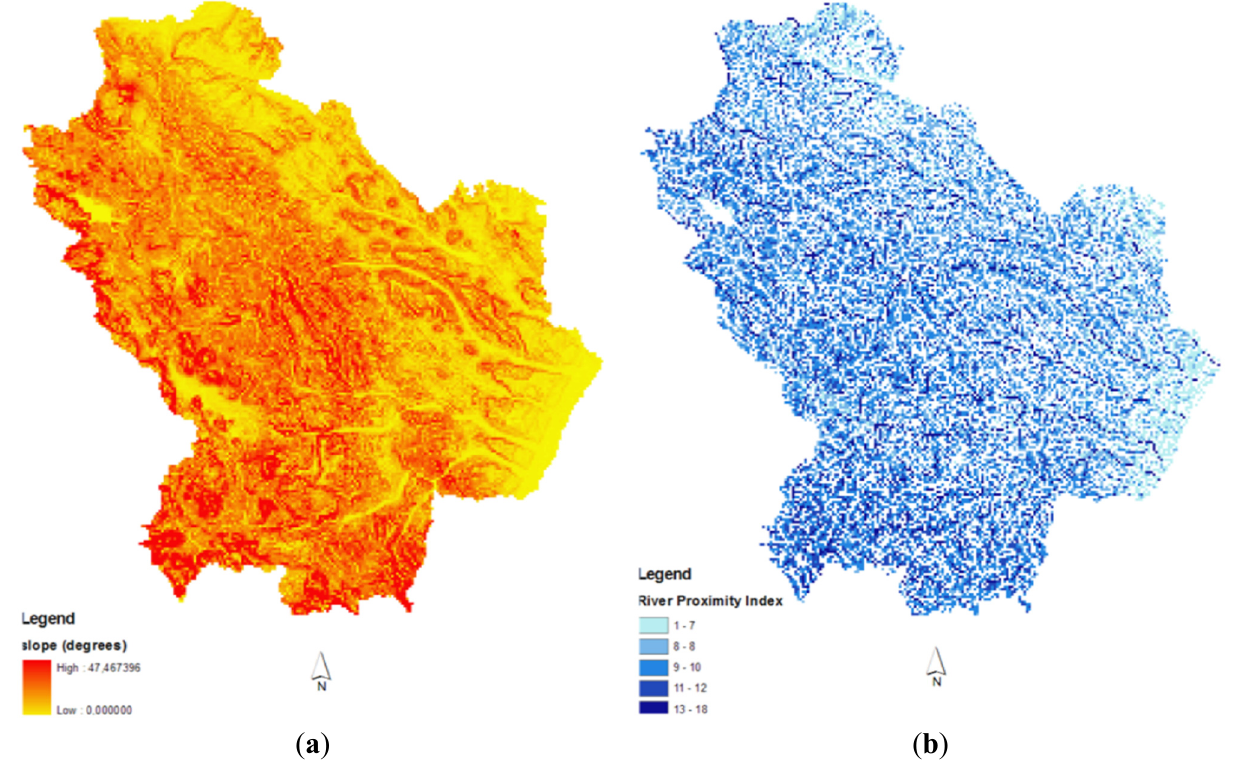
Figure 3. Maps of slope gradient ( a ) and river proximity index ( b